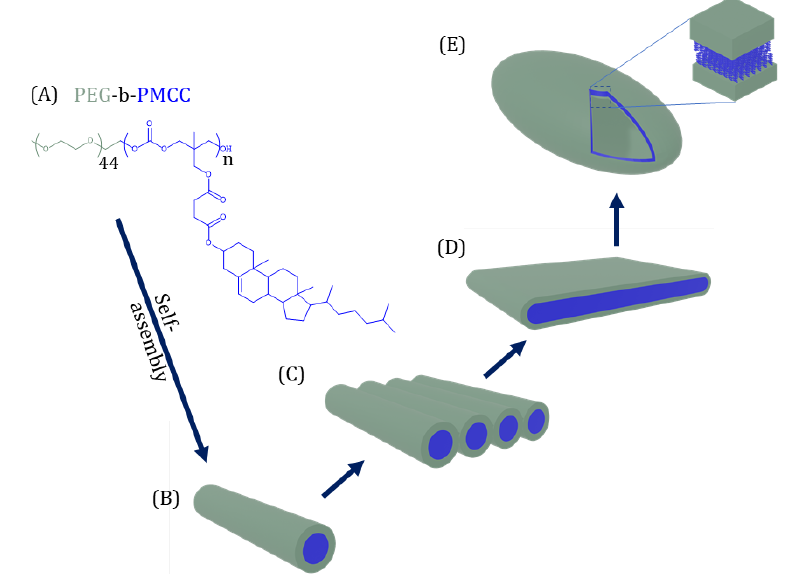
Figure 7. The morphological evolution of self-assembled nanostructures observed for PEG-b-PMCC BCP. ( A ) Chemical structure of PEG-b-PMCC BCP. The schematic representation of ( B ) the initial nanofibres formed, ( C ) the fusion of nanofibres, ( D ) the formation of lamella structure from fused nanofibres and ( E ) the rearrangement of lamellar structures into elliposidal vesicles with LC order within the